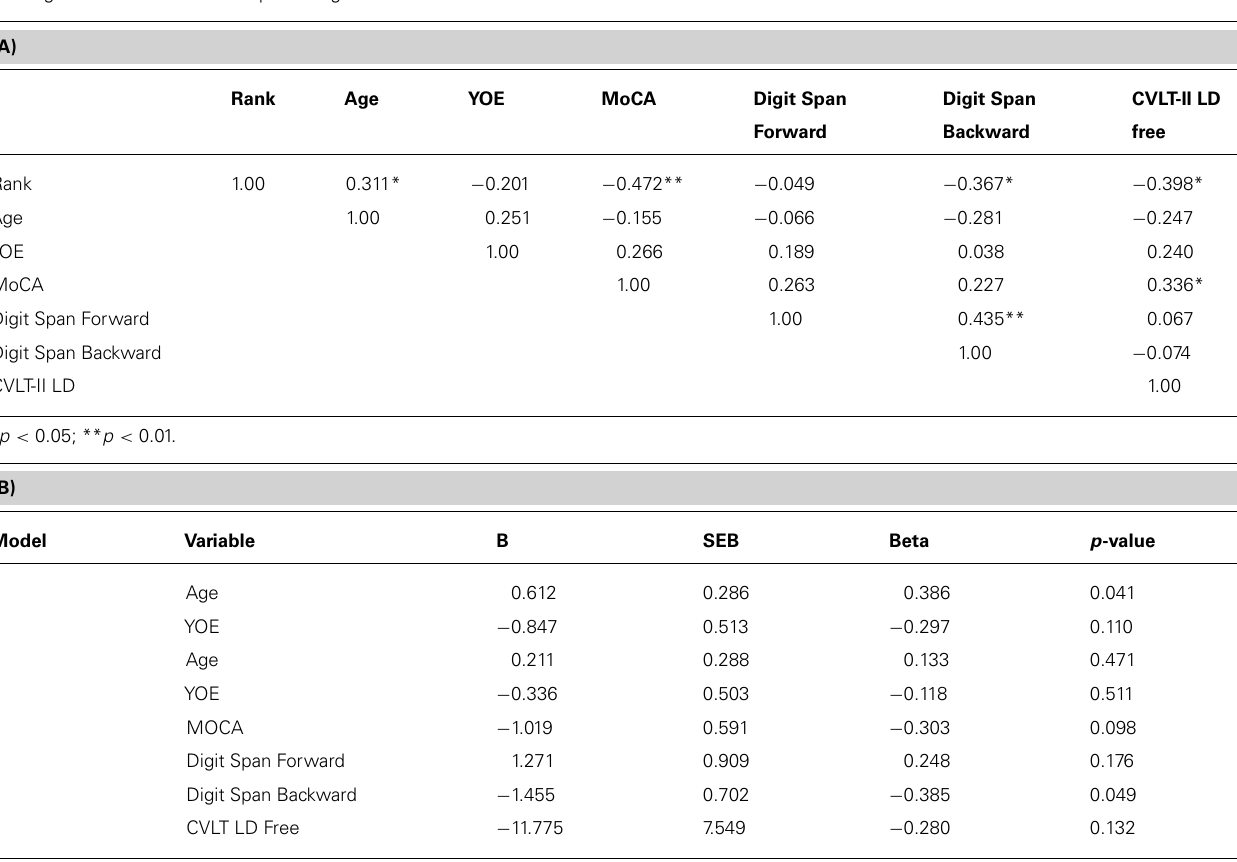
Table 4 | (A) Intercorrelations for Rank, MoCA, CVLT-II Long Delay Free Recall Proportion Accuracy (CVLT LD), and Digits Backward at baseline. (B) Hierarchical regression analysis summary for age, years of education (YOE), MoCA, CVLT-II Long Delay Free Recall (CVLT LD Free), Digits Forward, and Digits Backward at baseline predicting